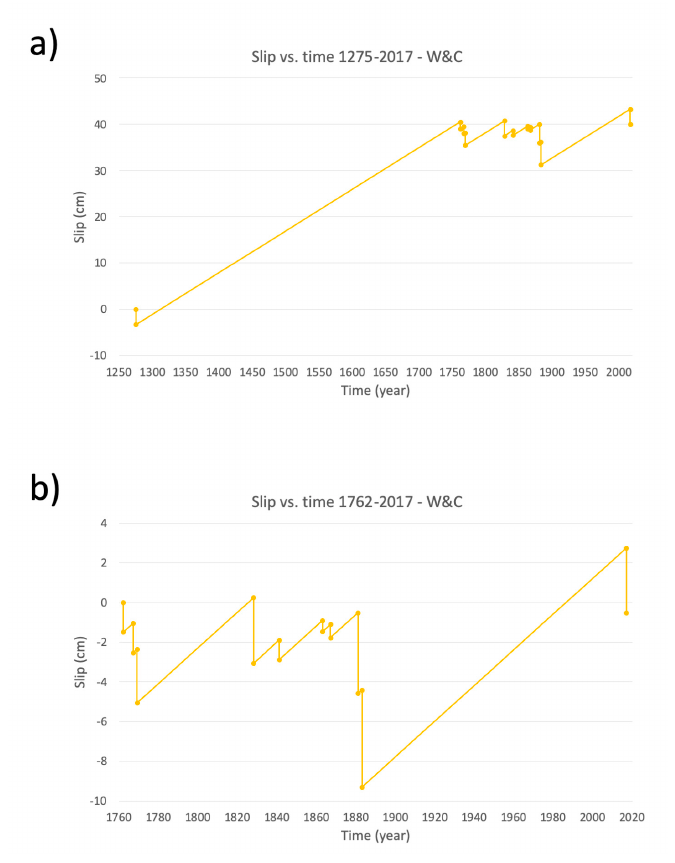
Figure 7. ( a ) Time functions describing the historical sequence of earthquakes (dots) that occurred on the CSf, as listed in historical catalogue CPTI15 [23] (Table S1); ( b ) time functions excluding the uncertain 1228 earthquake. In both panels, the vertical segments represent the coseismic slip as deduced from empirical relations linking magnitude to the average dislocation [48], while the oblique lines correspond to the long-term theoretical dislocation, as expected from the rate of aseismic slip observed on the creeping segment of the